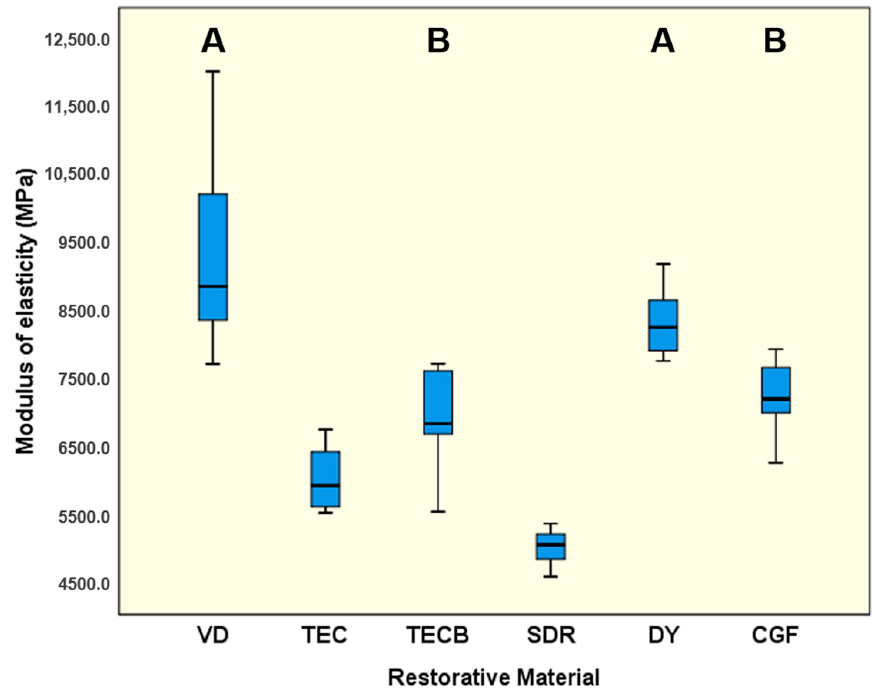
Figure 3. Modulus of elasticity (MPa). Identical uppercase letters denote no significant difference among calculated means of restorative materials ( p > 0.05) while different uppercase letters represent significant differences ( p < 0.05).